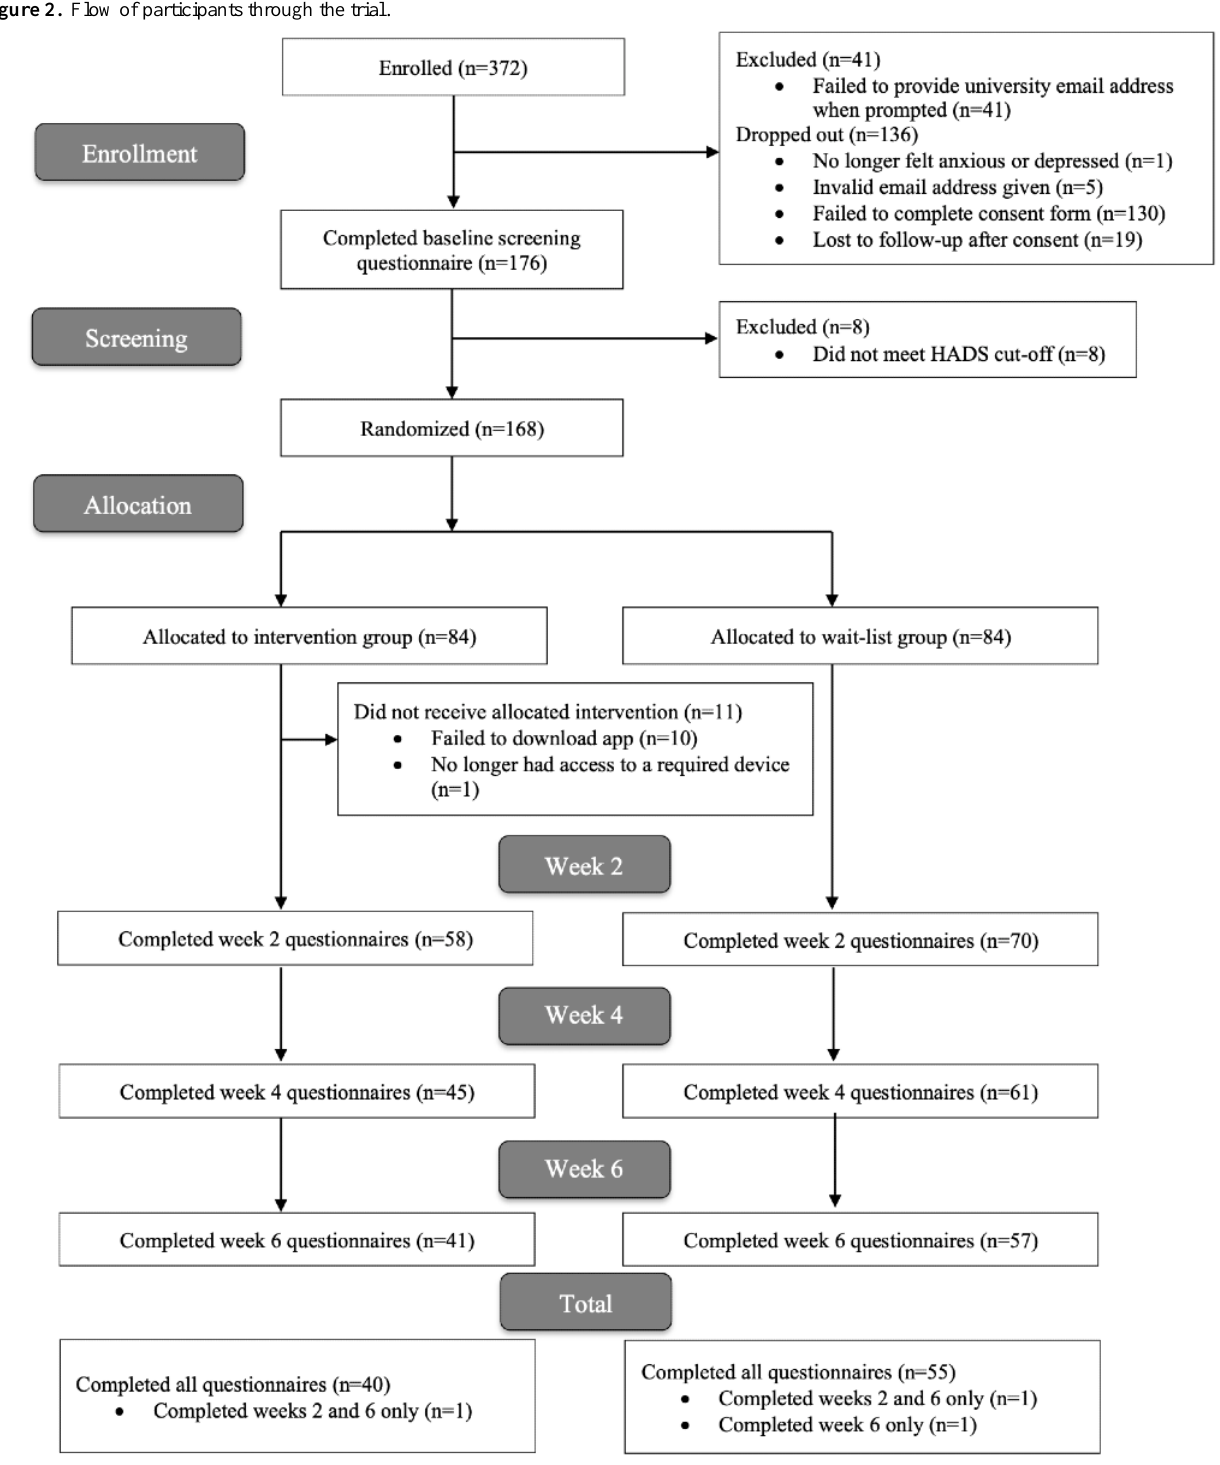
Figure 2. Flow of participants through the